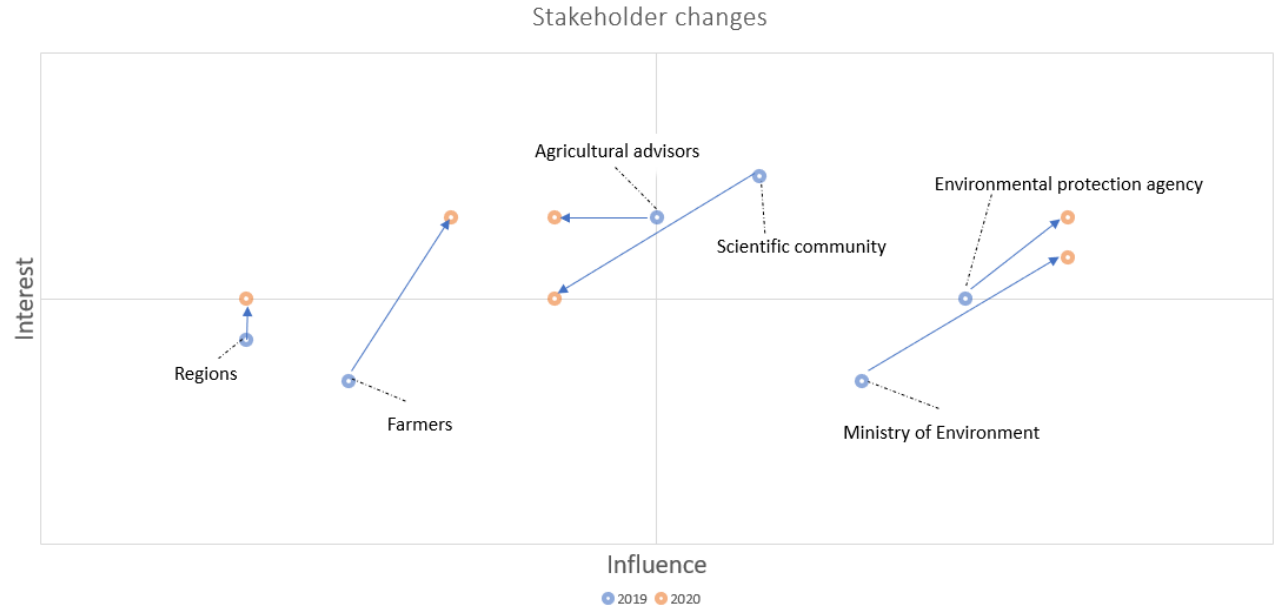
Figure 2. Stakeholder influence/interests matrix (selection of key stakeholders).